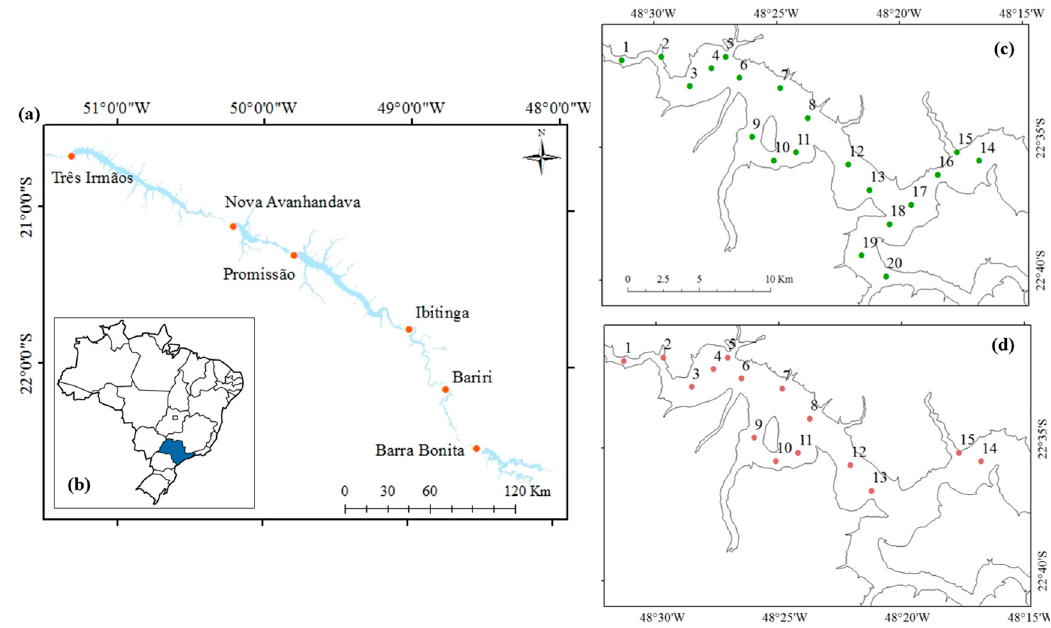
Figure 1. The Barra Bonita (BB) hydroelectric reservoir lies on ( a ) a cascading reservoir system in the Tietê River, ( b ) in São Paulo State, Brazil. Sampling stations randomly distributed along the reservoir for ( c ) May and ( d ) October field campaigns.